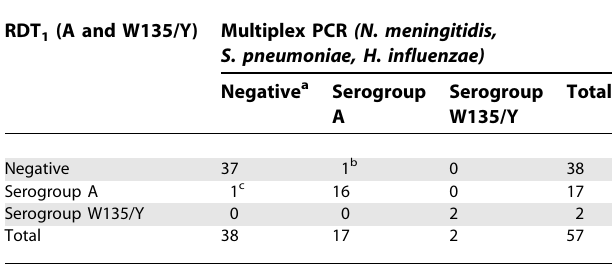
Table 2. Comparative Results of RDT 1 and PCR for CSF Samples from Patients with Suspected